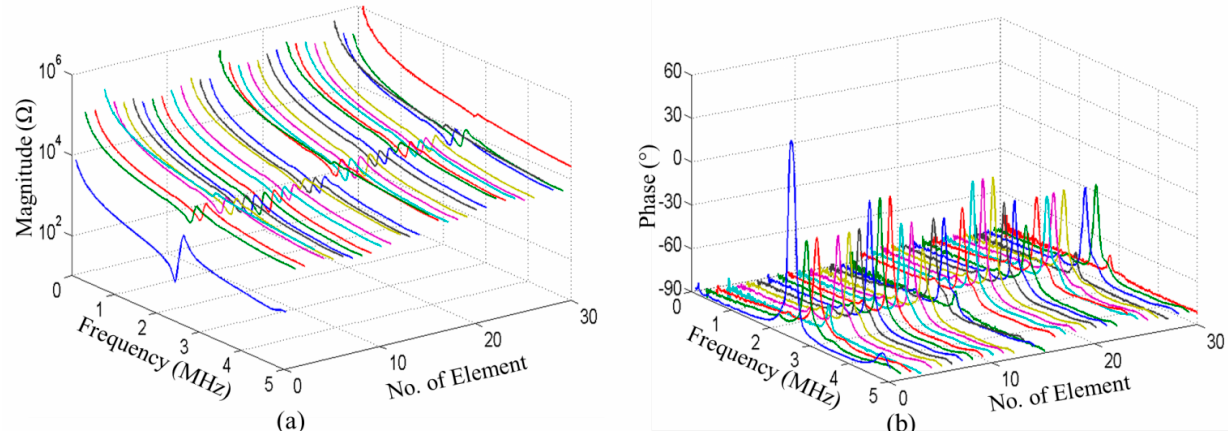
Figure 20. Impedance ( a ) magnitude and ( b ) phase of the 1-3 PMN-PT piezocomposite (No.0) and all 30 elements of the 1-D array